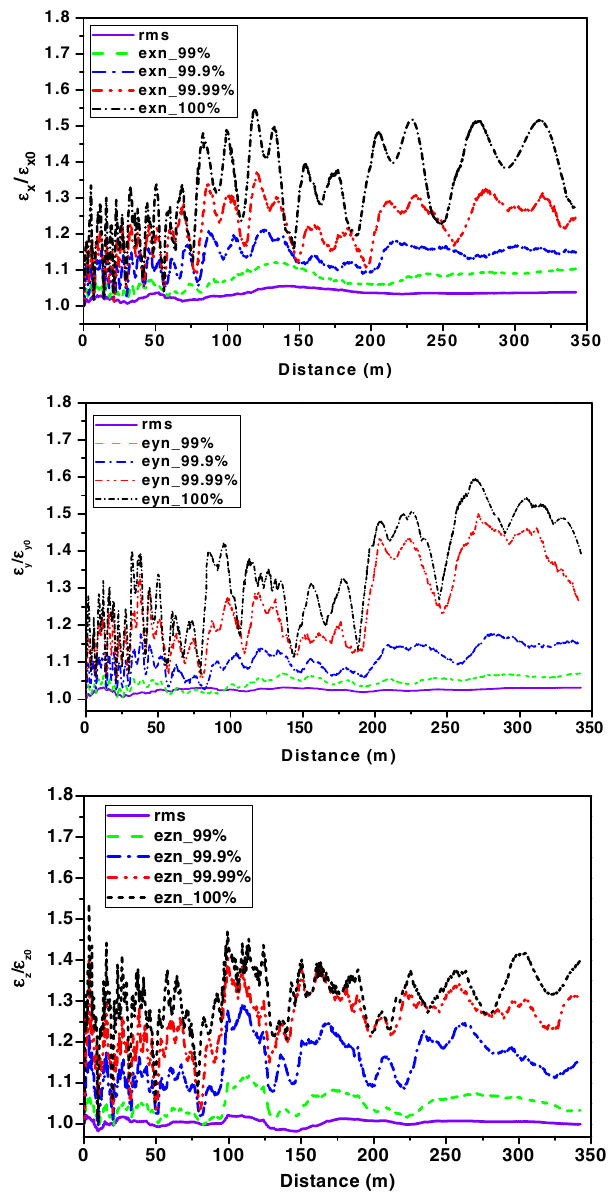
FIG. 24. Halo development along the main linac for different beam fractions. Emittances for different fractions are compared with the ones at the beginning of the main linac ( " ¼ 0 : 75 =k k x z